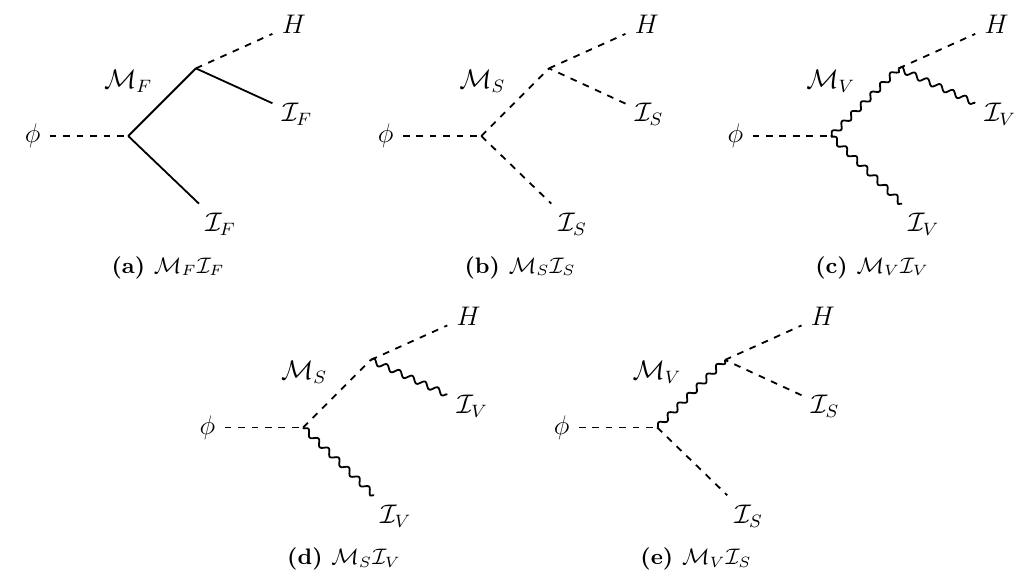
Figure 11. Mono-Higgs ( H ) + E miss